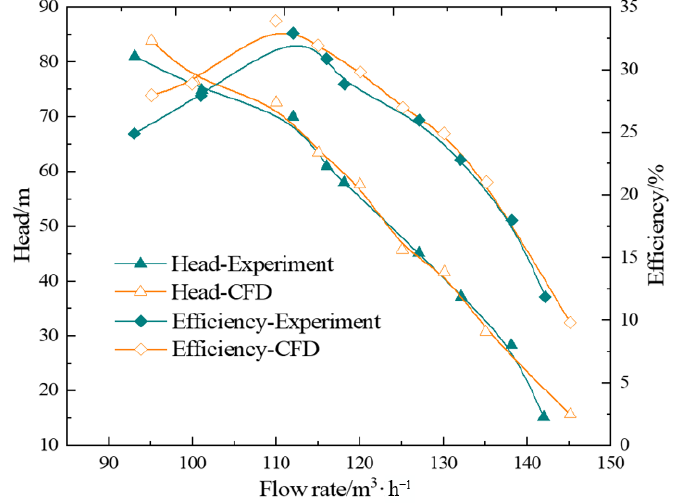
Figure 5. Hydraulic characteristics between CFD and experiment.